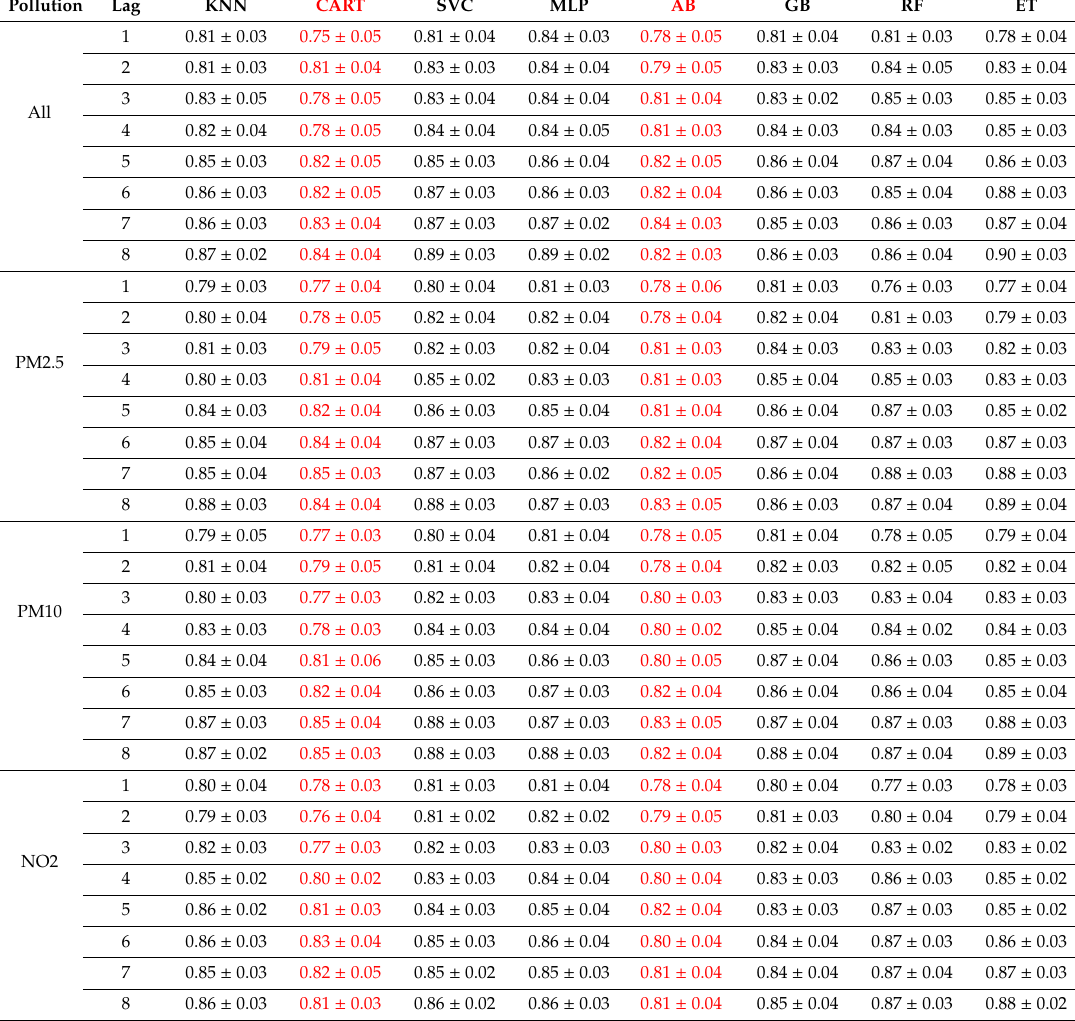
Table 1. Ten-fold cross-validation for all the eight ML models: F1 score (average and standard